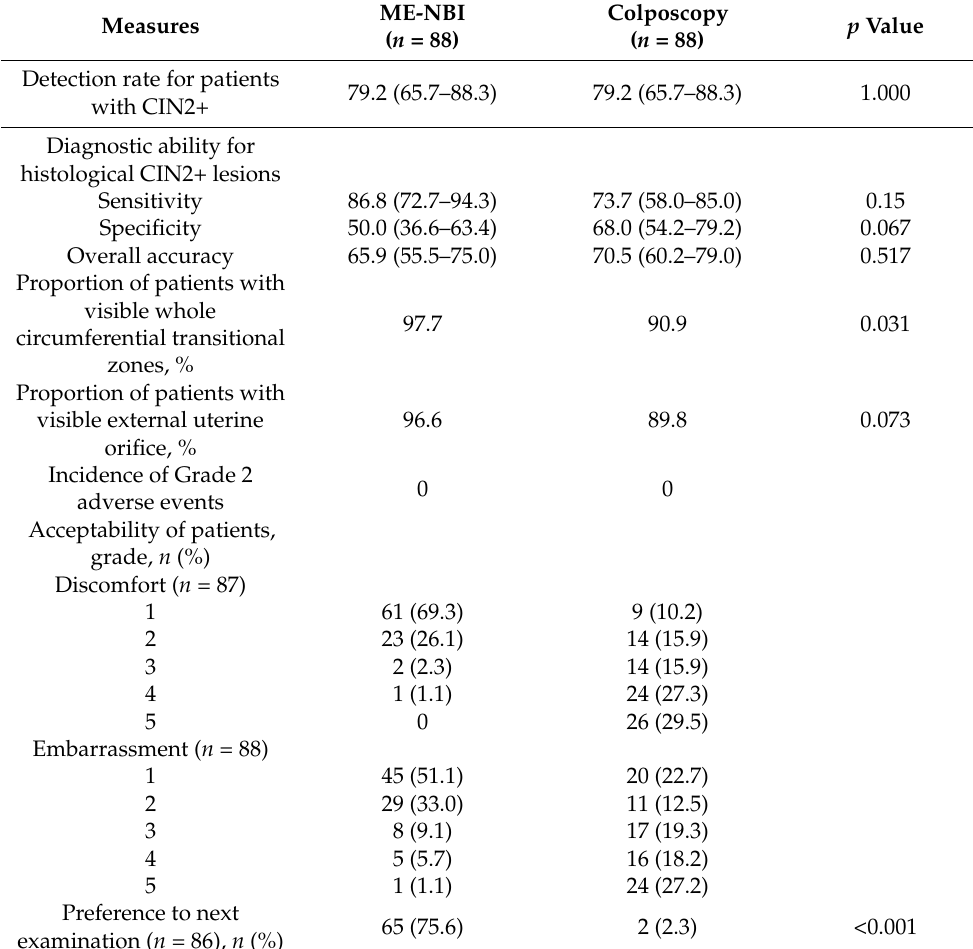
Table 2. Comparison of the primary and key secondary endpoints between ME-NBI and